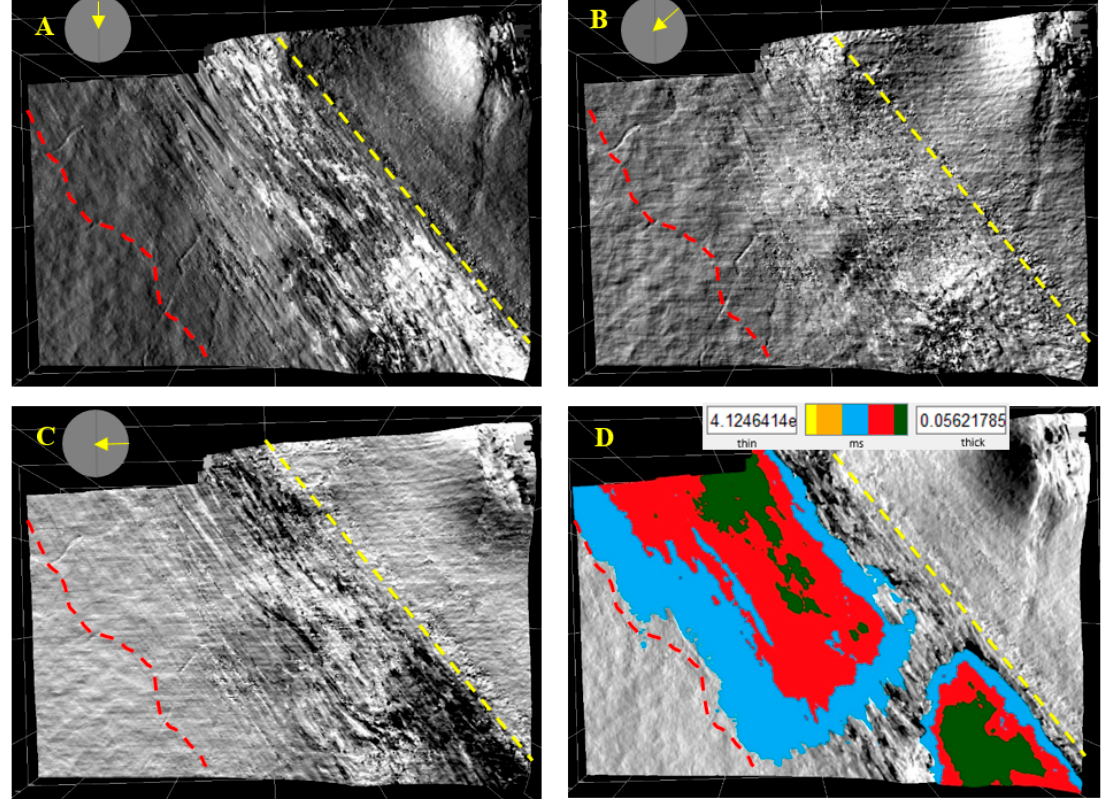
Figure 13. The apparent dip attributes for CC/SU1 surfaces at ( A ) 0°, ( B ) 45°, ( C ) 90°, and ( D ) the Isopach map. Isopach